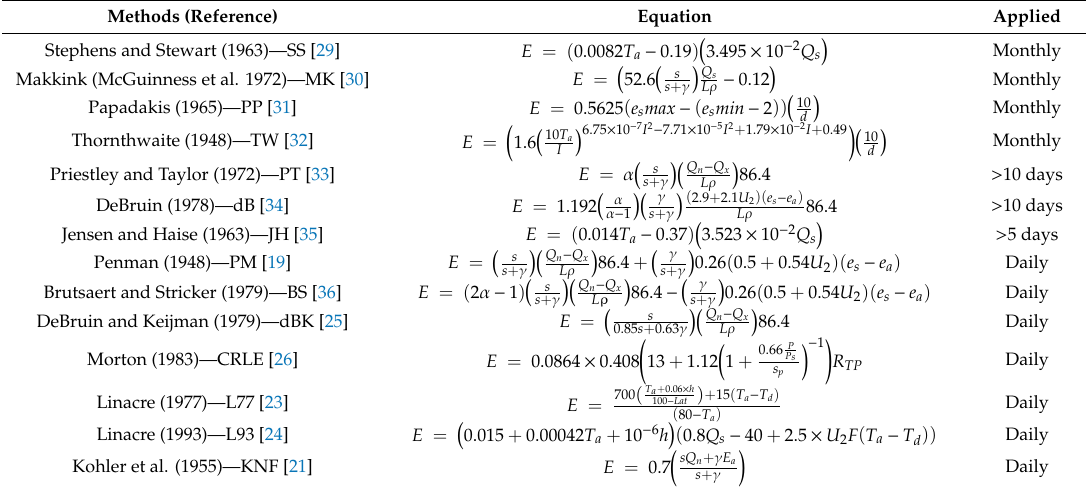
Table 1. Methods used in the estimation of